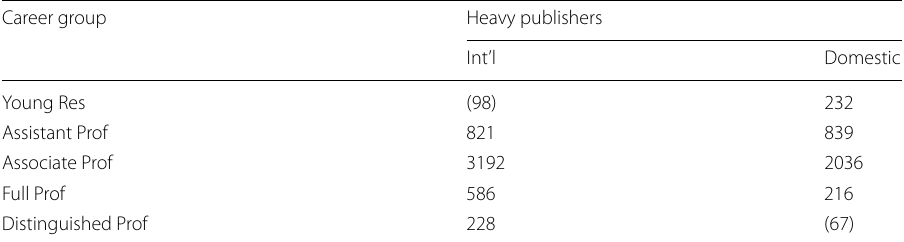
Table 7 Tally of heavier publishers (corresponding to the top 10% researchers from the productivity standpoint) in the different career and migration